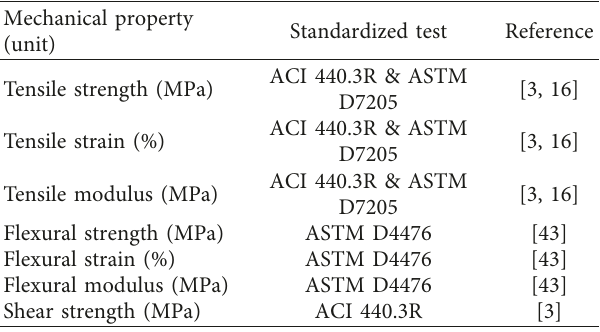
Figure 2: Percentage distribution of GFRP components. (a) Glass fiber material. (b) Matrix material. Table 3: Summary of standardized testing for mechanical